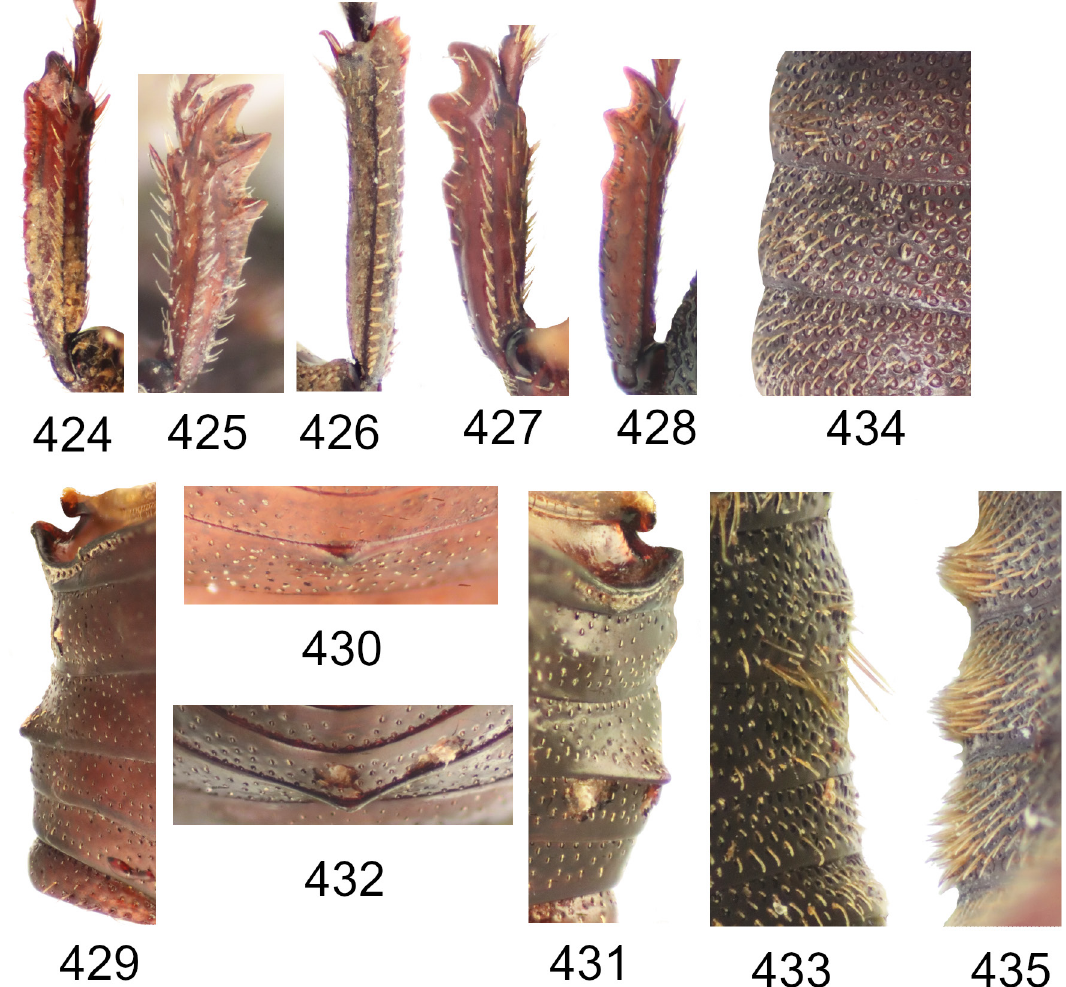
Figs 424–435. Papuan and Wallacean Maechidius Macleay, 1819, protibia, dorsal view (424–428), and abdominal ventrites (429–435), ventral and lateral views. 424 . M. ursus sp. nov., holotype, ♀ (NME). 425 . M. vicinus Heller, 1914, lectotype, ♀ (SNSD). 426 . M. weigeli sp. nov., holotype, ♂ (NME). 427 . M. woodlarkianus Heller, 1914, lectotype, ♀ (SNSD). 428 . M. yamdena sp. nov., paratype, ♂ (BMNH). 429 . M. dani sp. nov., holotype, ♂ (IECA). 430 . Same, different aspect (IECA). 431 . M. hamatus sp. nov., holotype, ♂ (IECA). 432 . Same, different aspect (IECA). 433 . M. sturnus Arrow, 1941, holotype, ♂ (BMNH). 434 . M. subcostatus Heller, 1895, lectotype, ♂ (SNSD). 435 . M. tarsalis Arrow, 1941, lectotype, ♂ (BMNH). Not to